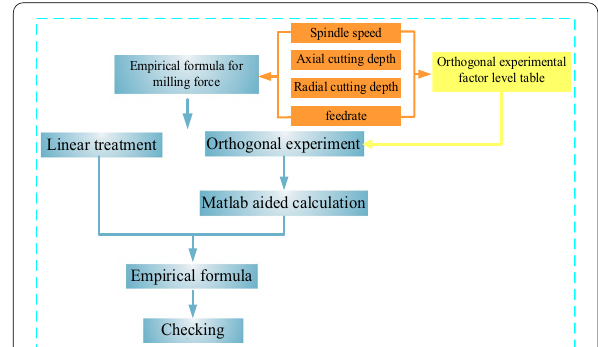
Figure 4 Empirical modeling